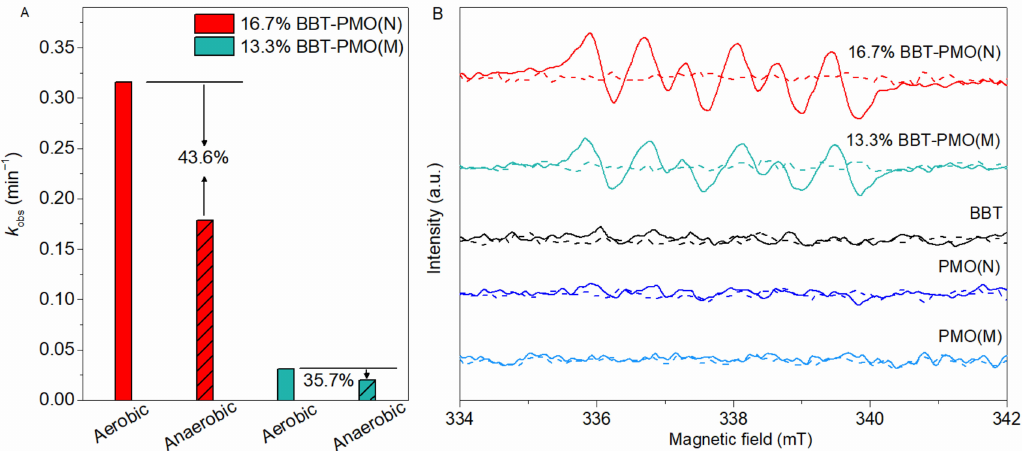
Figure 10. ( A ) Photoreduction rate constants of Cr(VI) over 16.7% BBT-PMO(N) and 13.3% BBT-PMO(M) under different atmospheres. ( B ) EPR spin-trapping signals of BBT, PMO(N), 16.7% BBT-PMO(N), PMO(M), and 13.3% BBT-PMO(M) for • O − . The dotted line is for light off and the solid line for the light 2